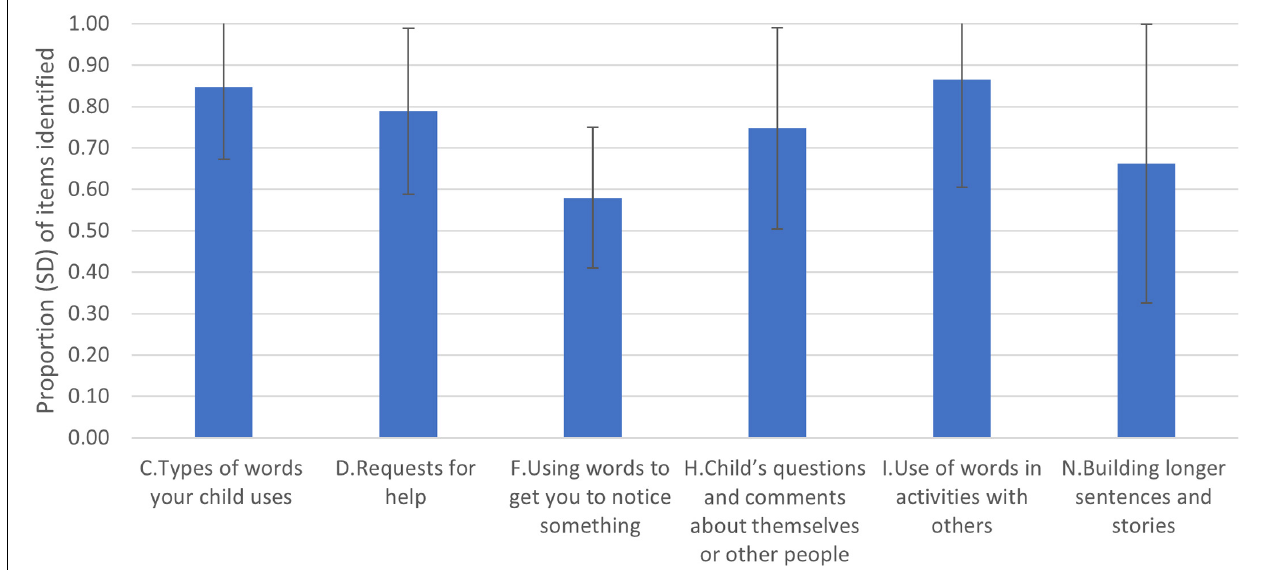
FIGURE 1 | Mean proportion of items (SD) recorded correct for use of English for each of the LUI subscales employed.